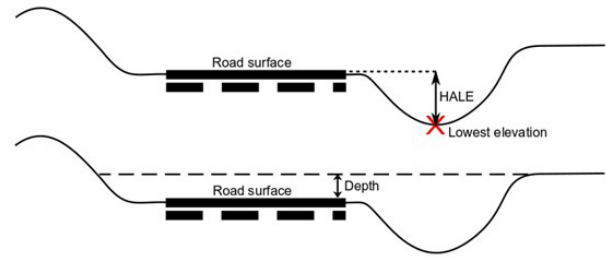
Figure 3. Schematic of HALE and depth